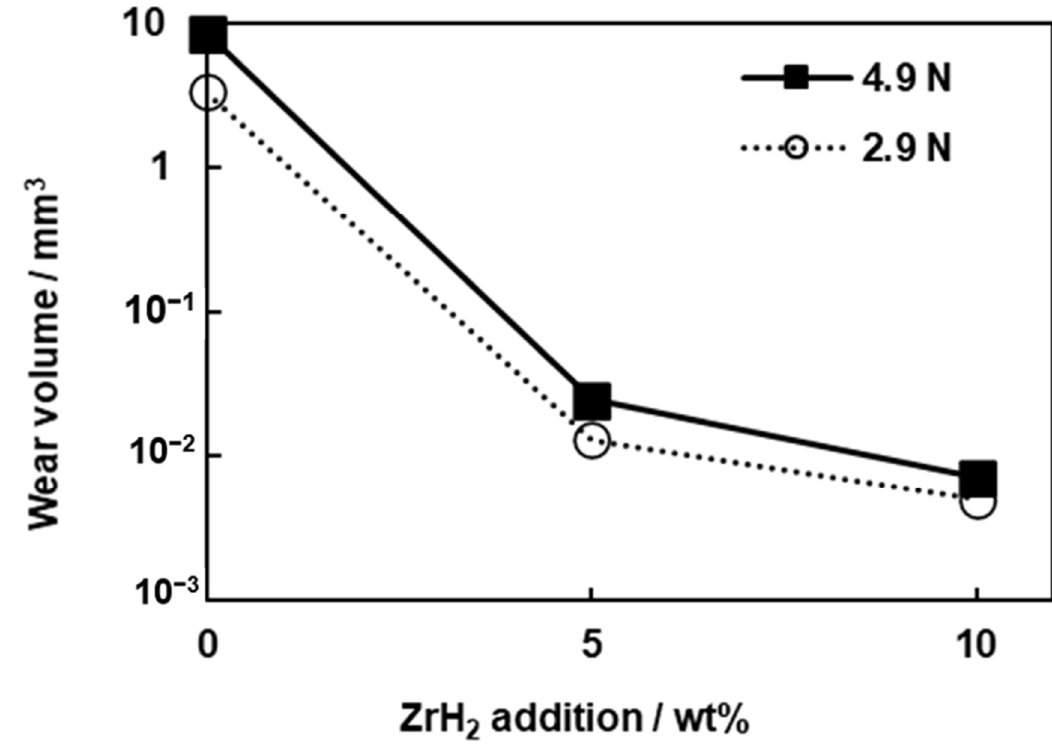
Figure 7. Wear volume averaged thrice for pure Al, –5, and –10 wt% ZrH 2 pin specimen under applied loads of 2.9 and 4.9 N.